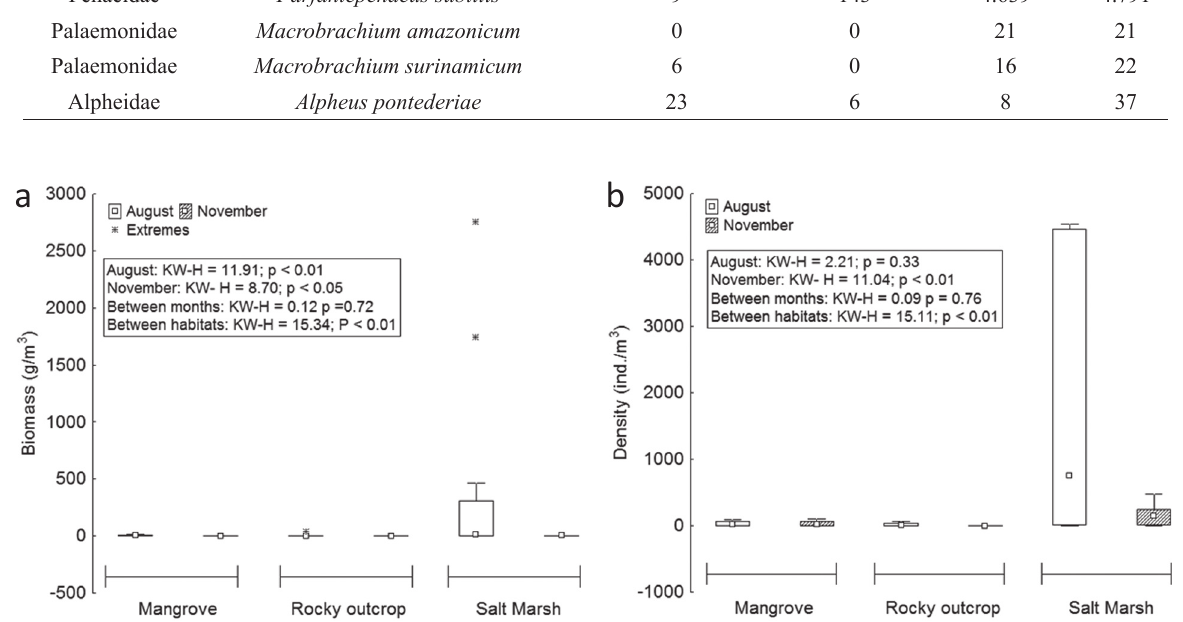
Figure 4 - Abundance in three habitats on Areuá Beach, Guarás Island, Curuçá, State of Pará, Brazilian Amazon. A = biomass (g/m 3 ); and B = density (ind/m 3